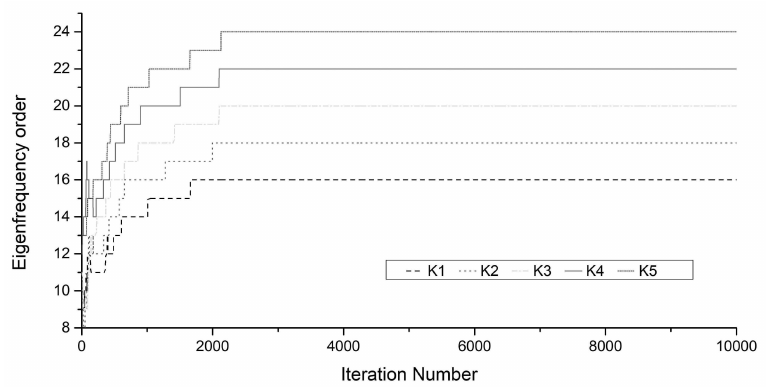
Figure 9. Convergence of the model order.